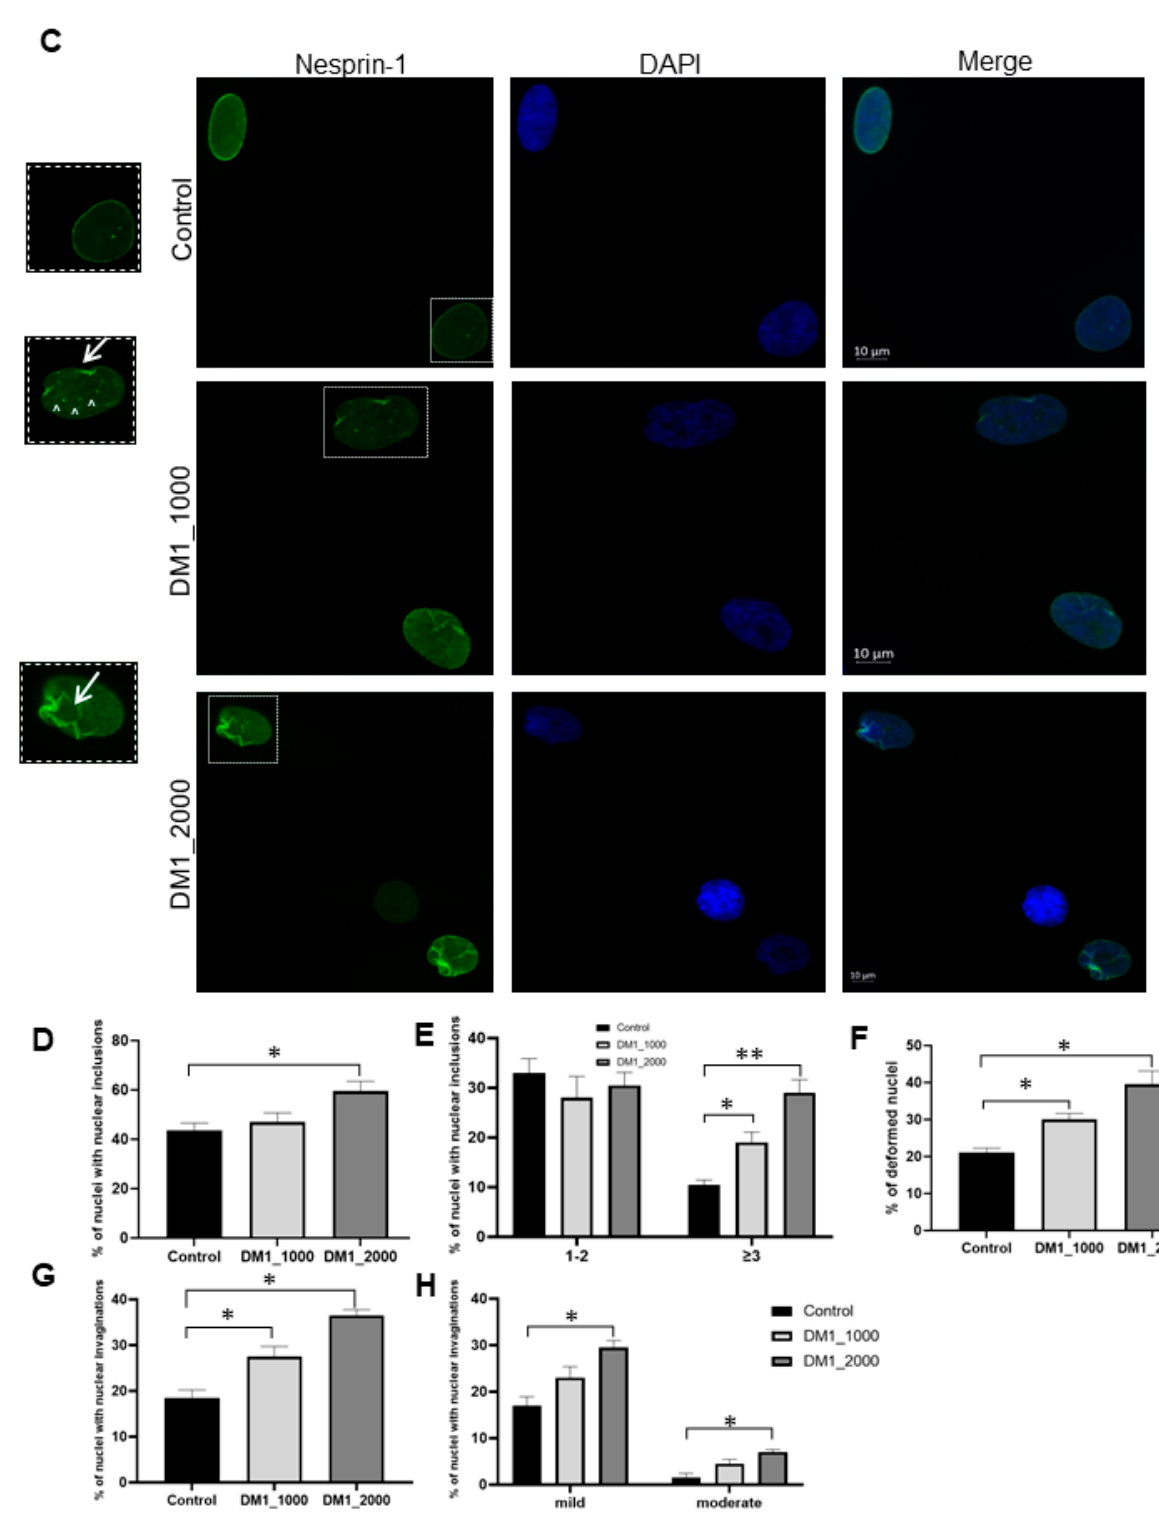
Figure 7. Intracellular protein levels and nuclear localization of nesprin-1 in DM1 patient-derived and control fibroblasts. ( A ) Intracellular nesprin-1 protein levels in DM1 patient-derived and control fibroblasts. The intracellular protein levels in DM1 patient-derived fibroblasts were estimated in relation to protein levels detected in the control condition and are presented as mean ± SEM of four independent experiments. Ponceau S staining was used to assess gel loading. The statistical analysis was performed using one-way ANOVA followed by Tukey’s multiple comparison test to compare between DM1_1000, DM1_2000 and the control groups. * p < 0.05. ( B ) Intracellular nesprin-2